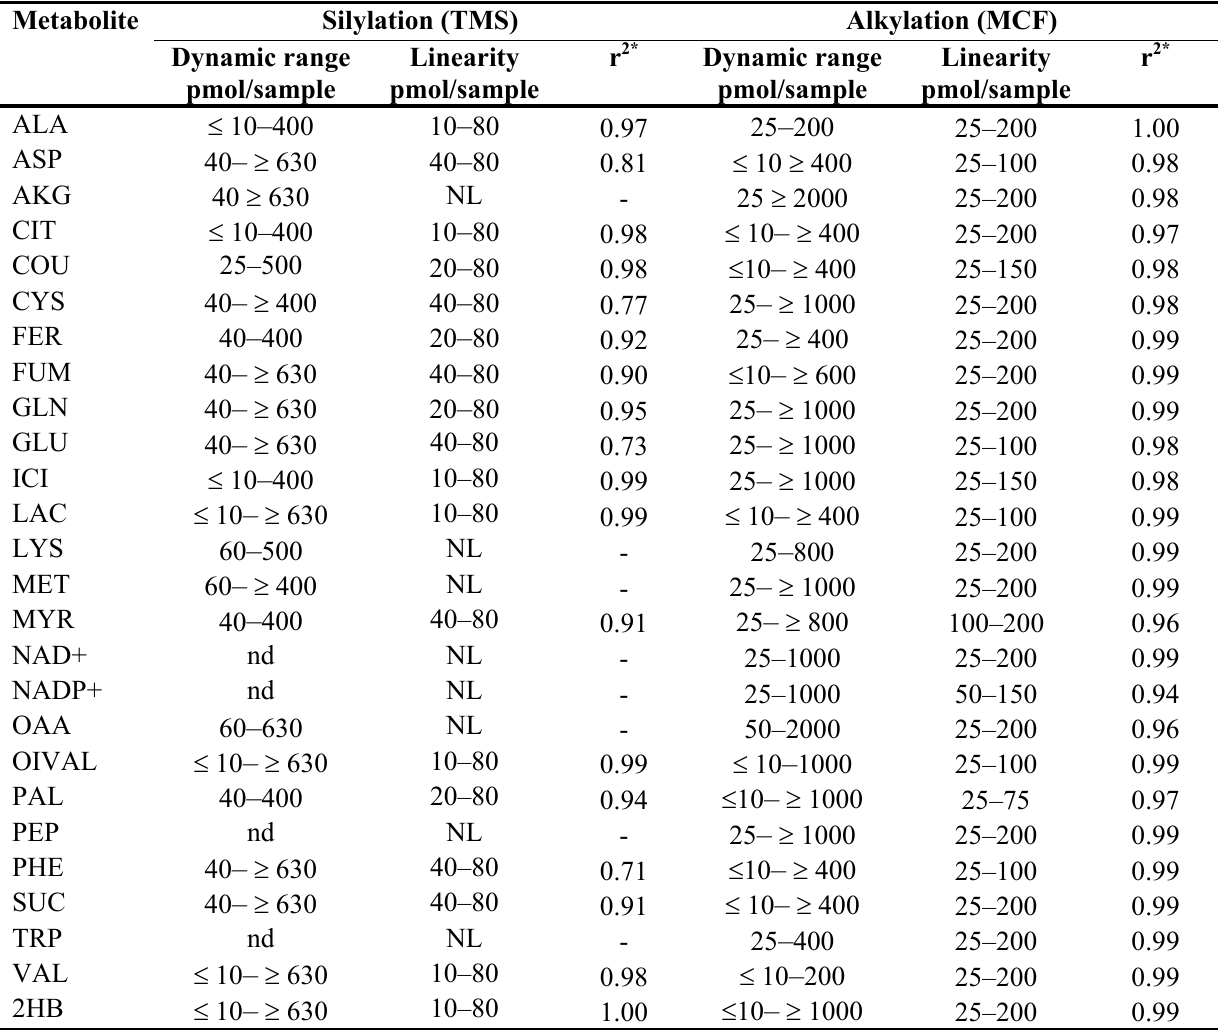
Table 4. Linearity and dynamic range of several metabolite